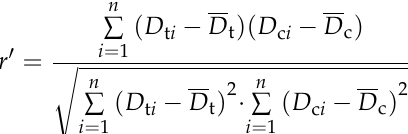
the construction of the cloud trajectories.